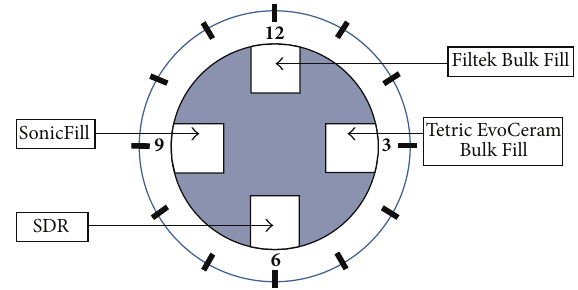
Figure 2: Order of restorations in every tooth